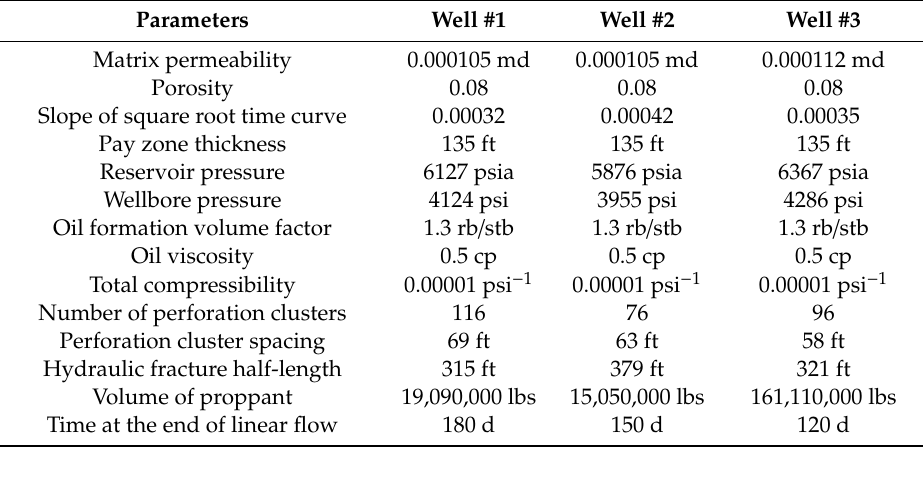
Table 1. Reservoir and well completion data.